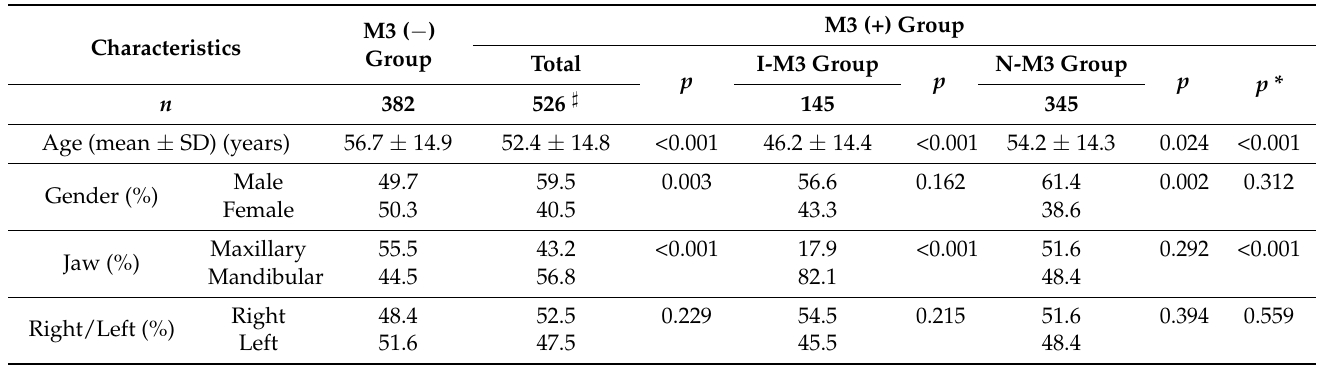
Table 2. Characteristics of the quadrants with extracted M2s ( n = 908)